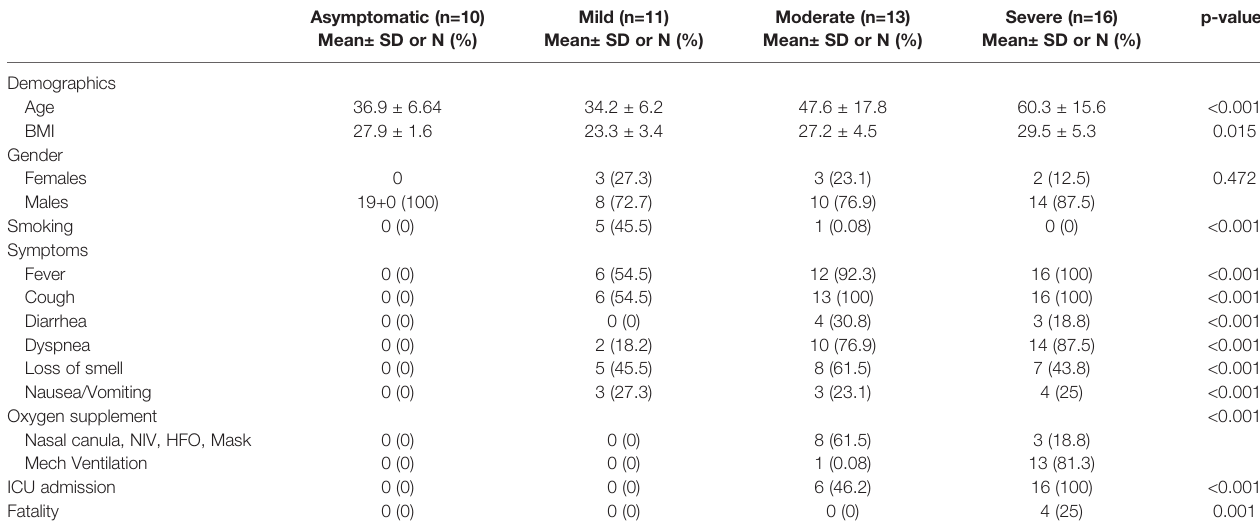
TABLE 1 | Demographic and Clinical data of the exploratory cohort (COVID-19 patients tested by transcriptomics analysis of nasopharyngeal